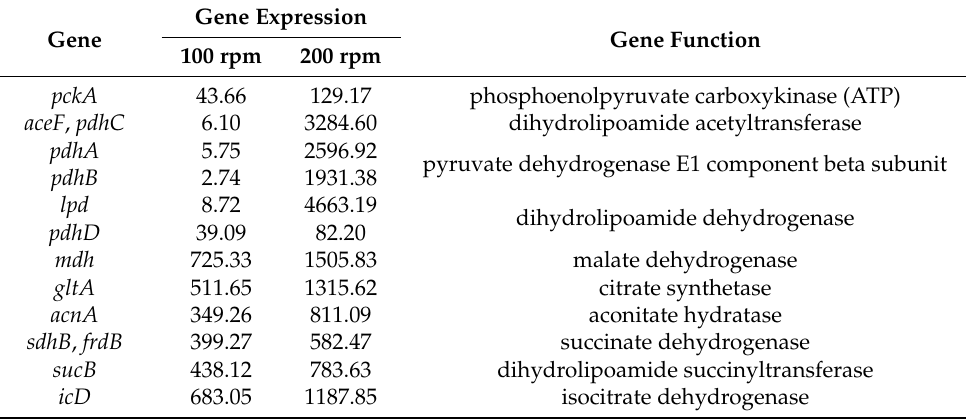
Table 1. The TCA gene expression in Bacillus velezensis CMT-6 at different dissolved oxygen concentrations. Gene Gene